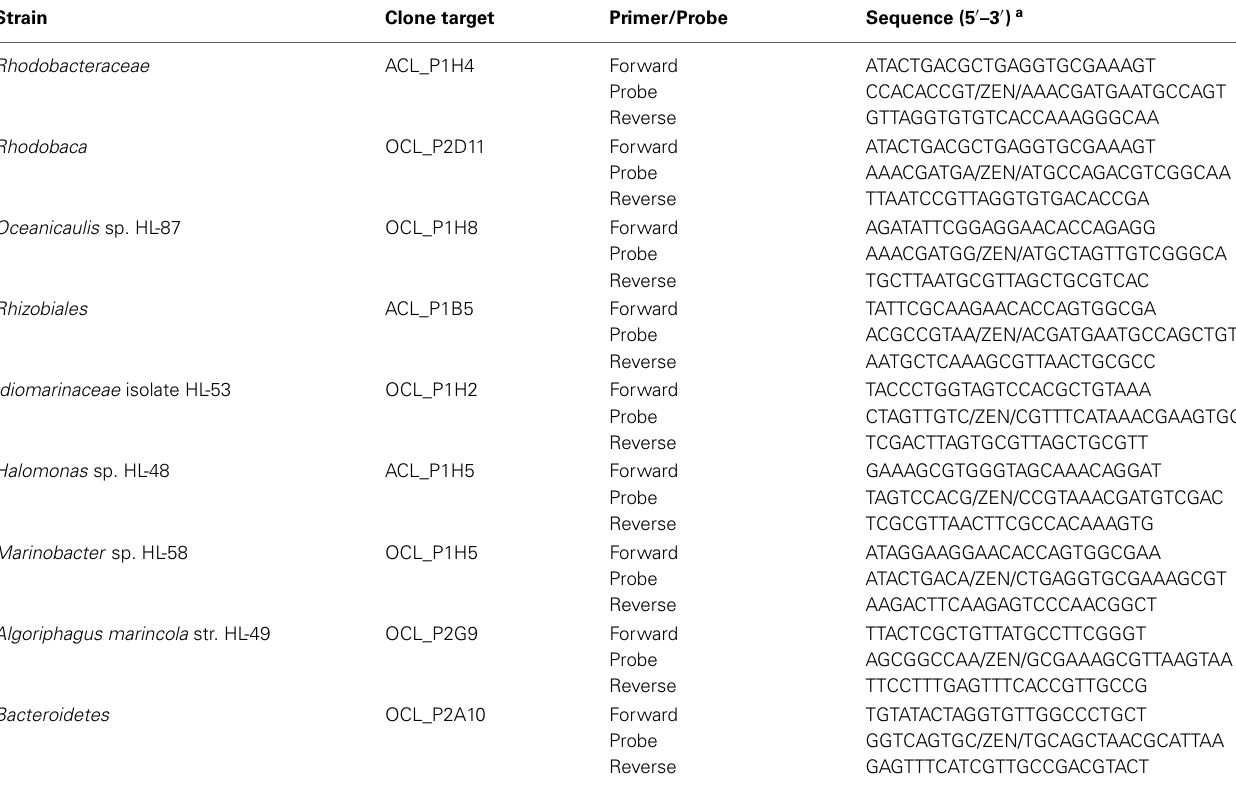
Table 1 | Real-time PCR primers and